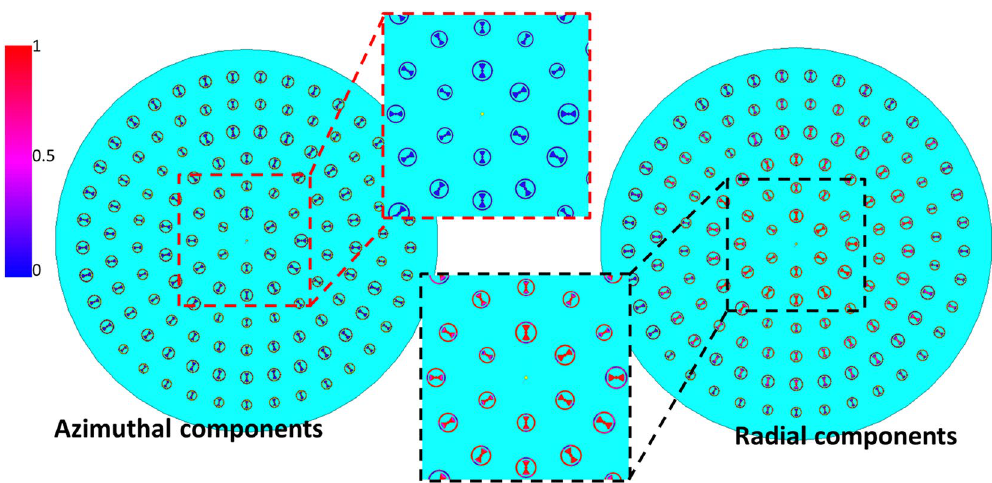
Figure 5. The magnitude of the radial and azimuthal component of surface currents of the RHCP